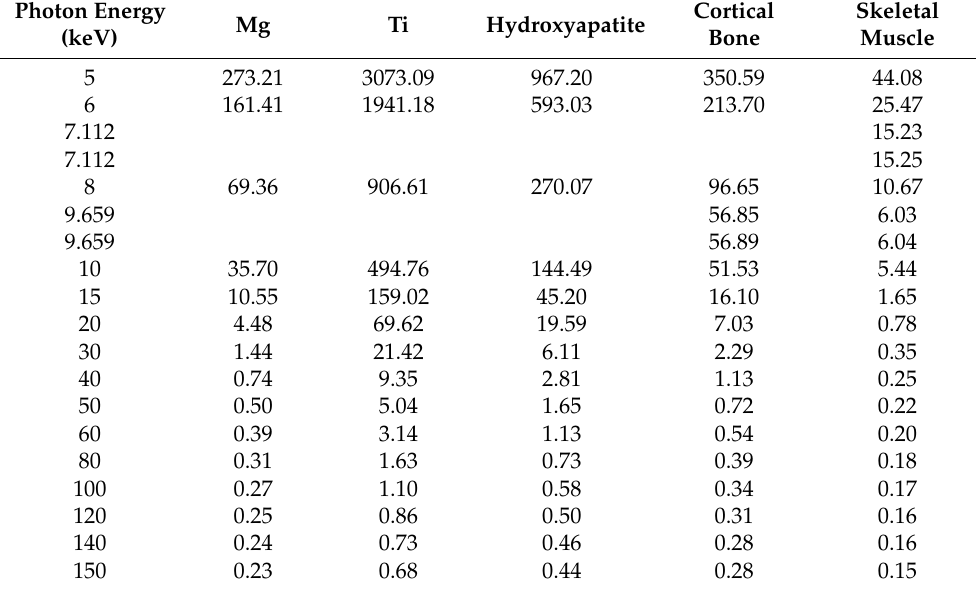
Table 2. Calculated linear attenuation coefficients (cm − 1 ) for biodegradable implant materials (magnesium and hydroxyapatite), titanium, cortical bone and skeletal muscle from to 5 to 150 keV. Values can vary depending on structure and